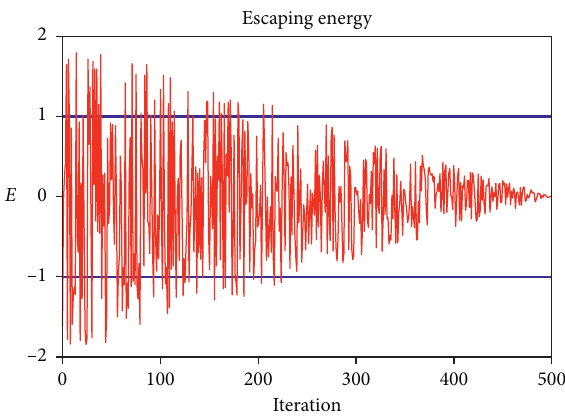
Figure 1: Energy change curve of the